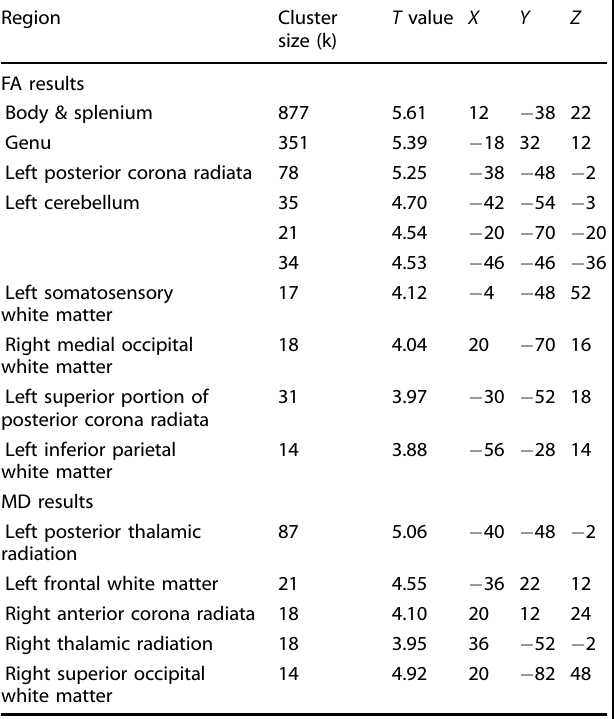
Table 1. Clusters that showed a signi fi cant microstructural decline in the paired t tests comparing FA/MD at the baseline and 24-month follow-up time-points.